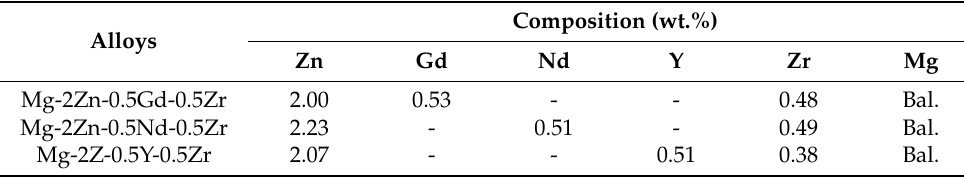
Table 1. Actual composition of the three alloys. Composition (wt.%) Alloys Zn Gd Nd Y Zr